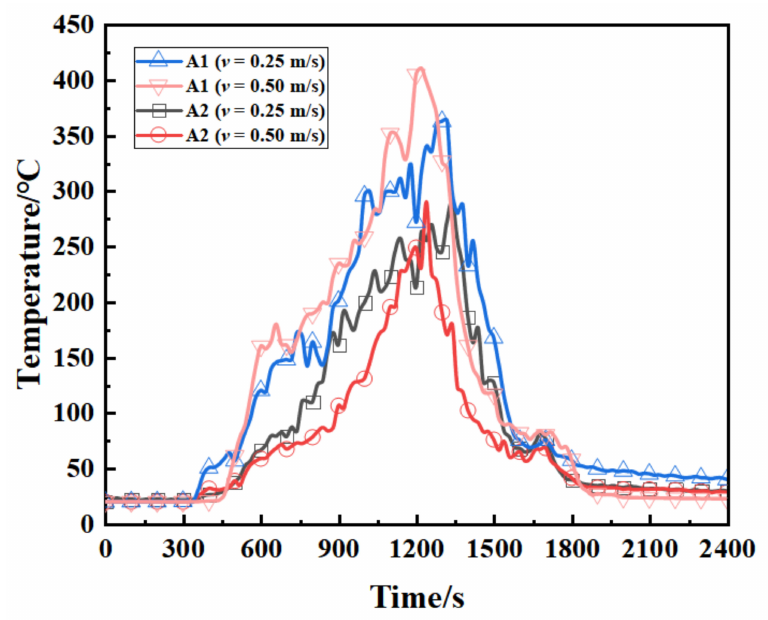
Figure 16. Temperature upstream and downstream of the fire